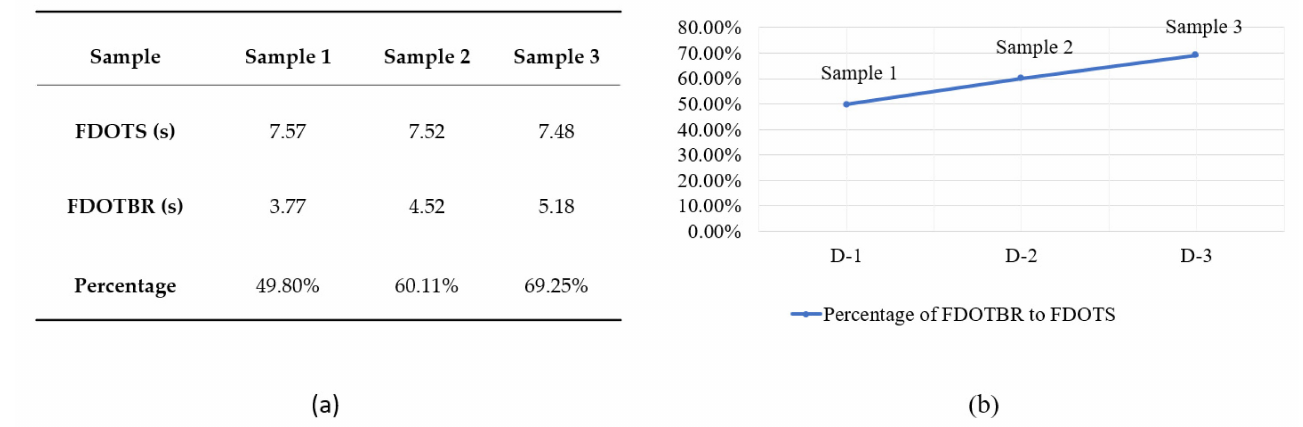
Figure 4. Analysis of fixation time in the experiment 1: ( a ) Data related to fixation time in the experiment 1 and ( b ) relationship between the percentage of FDOTBR to FDOTS, and the distribution of building blocks (the experiment 1).